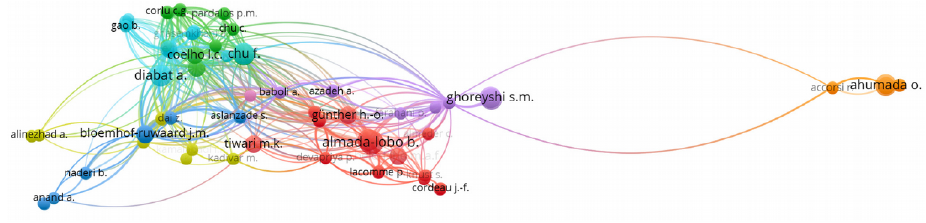
Figure 3. Citation network analysis